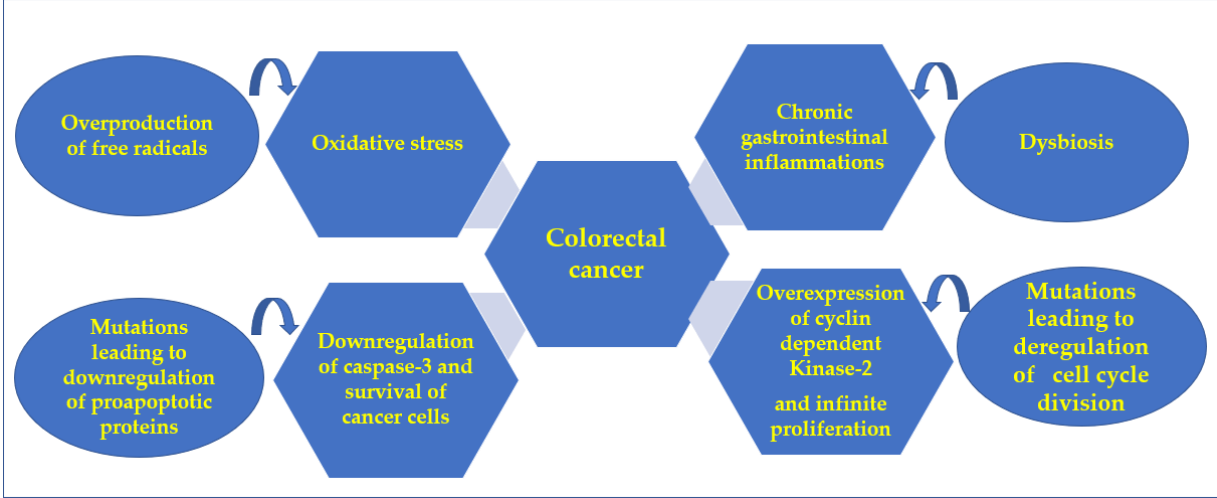
Figure 1. Background of this work.